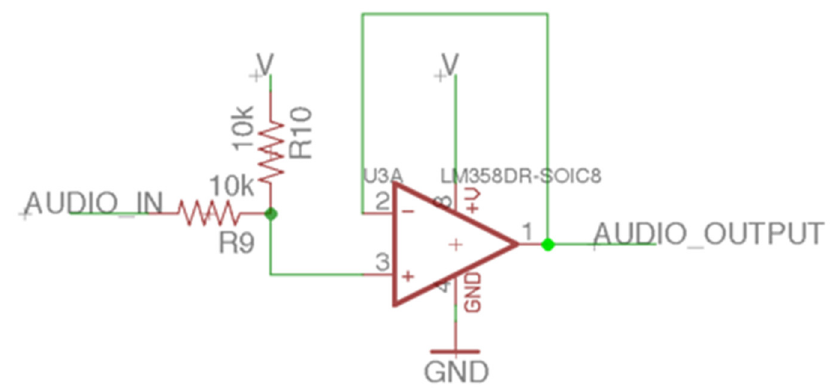
Figure 8. The audio signal input circuit of the laser audio transmission device.